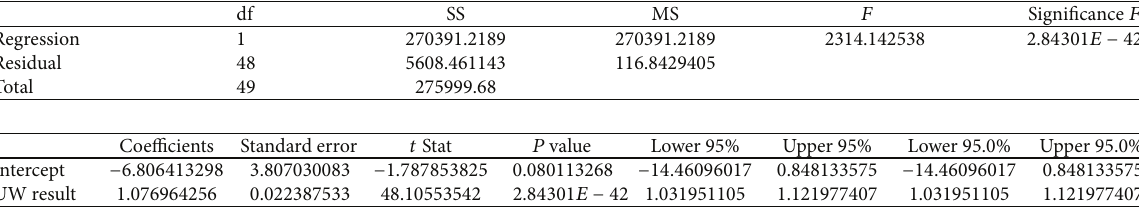
Figure 3: Correlation between LC/MS/MS in-house analysis of urine and UW Medical Center’s analysis of duplicate urine samples using an automated Jaff´e reaction.